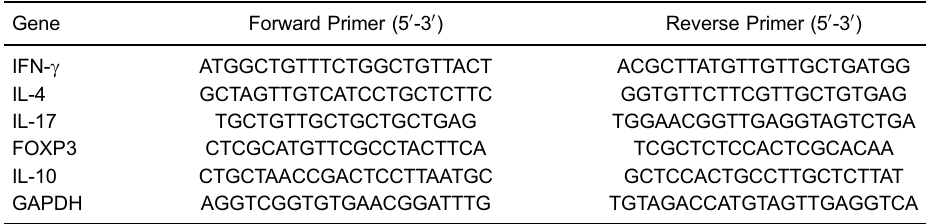
Table 1. Primers used in